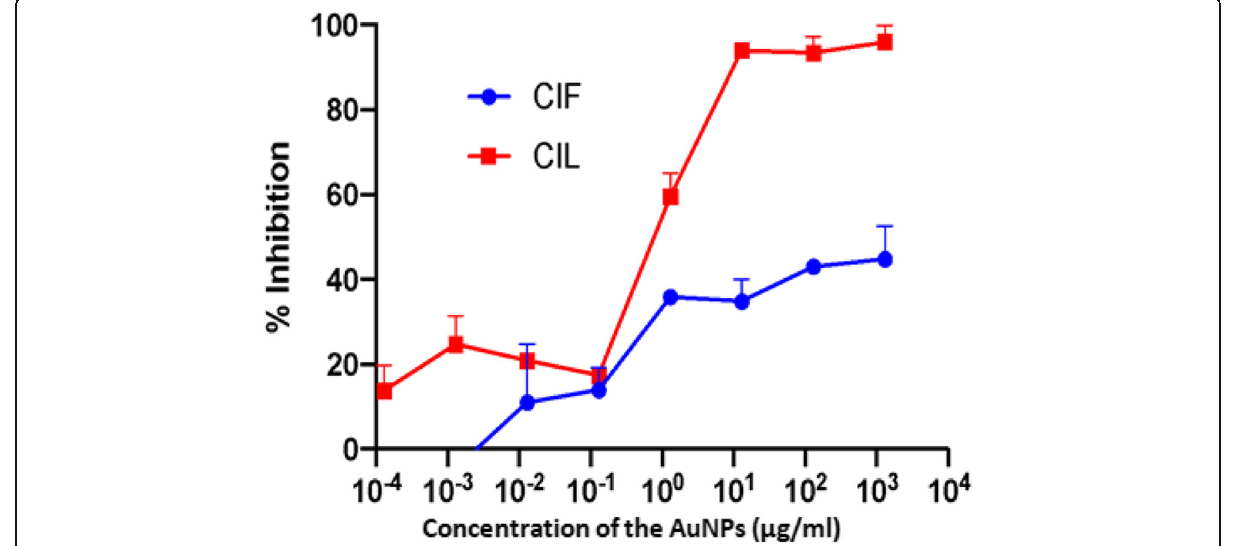
Fig. 10 TZM-bl cell lines EC 50 concentration graph of the tested NPs